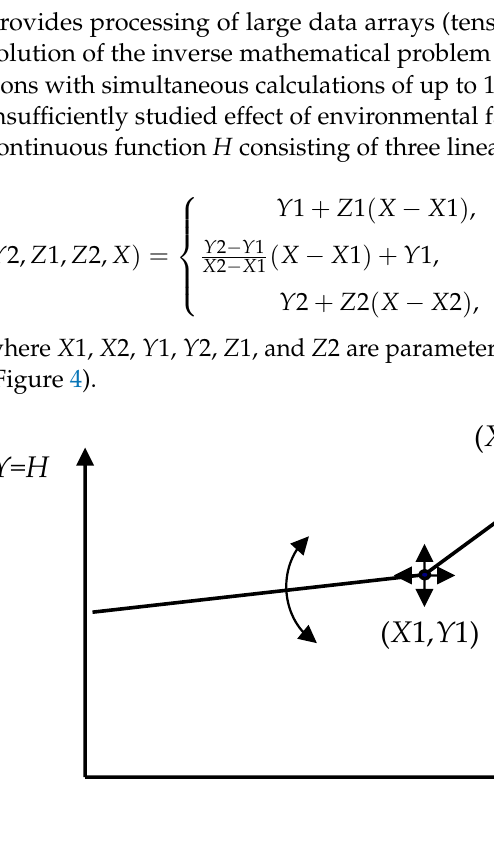
Figure 4. Continuous function H(X 1, X 2, Y 1, Y 2, Z 1, Z 2, X) consisting of three linear fragments with arbitrarily changing parameters in Equation (1)